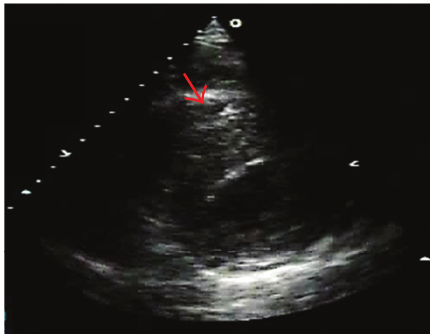
Figure 6: Increased interventricular septum thickness and abnormal motion by postprocedural echocardiography.